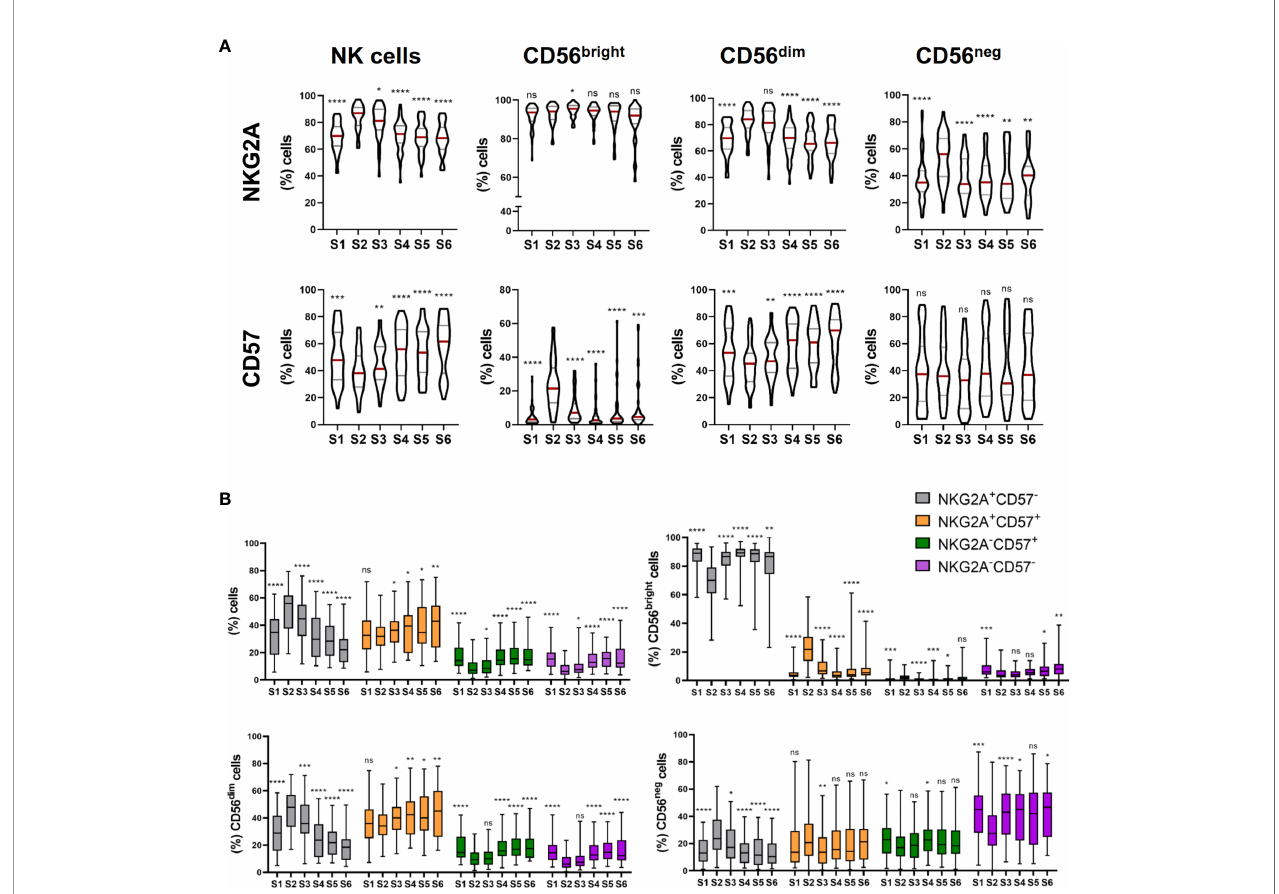
FIGURE 2 | NK cells exhibit a predominantly immature phenotype shortly after autoHSCT. (A) , (upper panel) Violin plots showing the percentage of NKG2A+ cells within total NK cells and CD56 bright , CD56 dim and CD56 neg NK cell subsets at the six studied time points (S1-S6). (A) , (lower panel) Violin plots showing the percentage of CD57+ cells within total NK cells and CD56 bright , CD56 dim and CD56 neg NK cell subsets. (B) Boxplot graphs showing the percentage of NKG2A+CD57-, NKG2A+CD57+, NKG2A- CD57+ and NKG2A-CD57- within total NK cells (upper line, left) and within CD56 bright (upper line, right), CD56 dim (bottom line, left), CD56 neg (bottom line, right) NK cells. Violin plots show the median and the quartiles. Boxplots show the median and 25 – 75th percentiles, and the whiskers denote lowest and highest values (S1 n=54; S2 n=45; S3 n=45; S4 n=43; S5 n=37; S6 n=37). Signi fi cance of data was determined by comparing each sample with sample S2. *p < 0.05, **p < 0.01, ***p < 0.001, ****p < 0.0001 and ns, no signi fi cant (t test for paired values or Wilcoxon matched-pairs signed rank